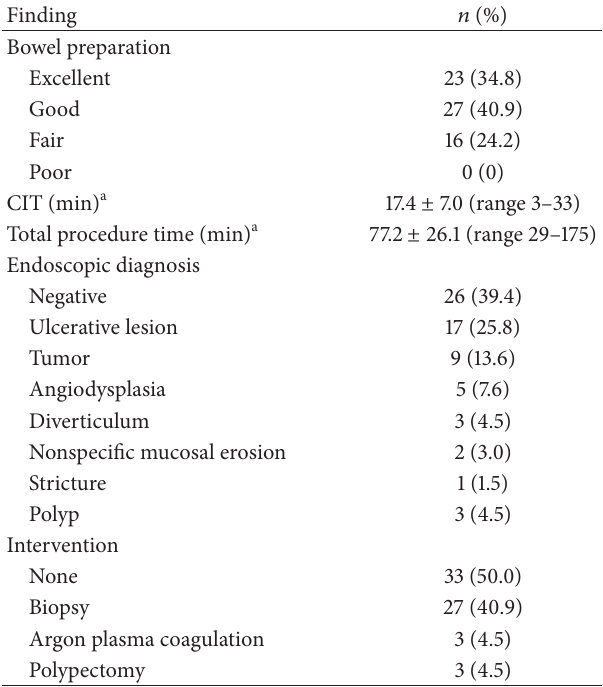
Table 2: The endoscopic findings of retrograde SBE ( 𝑛 = 66 ).